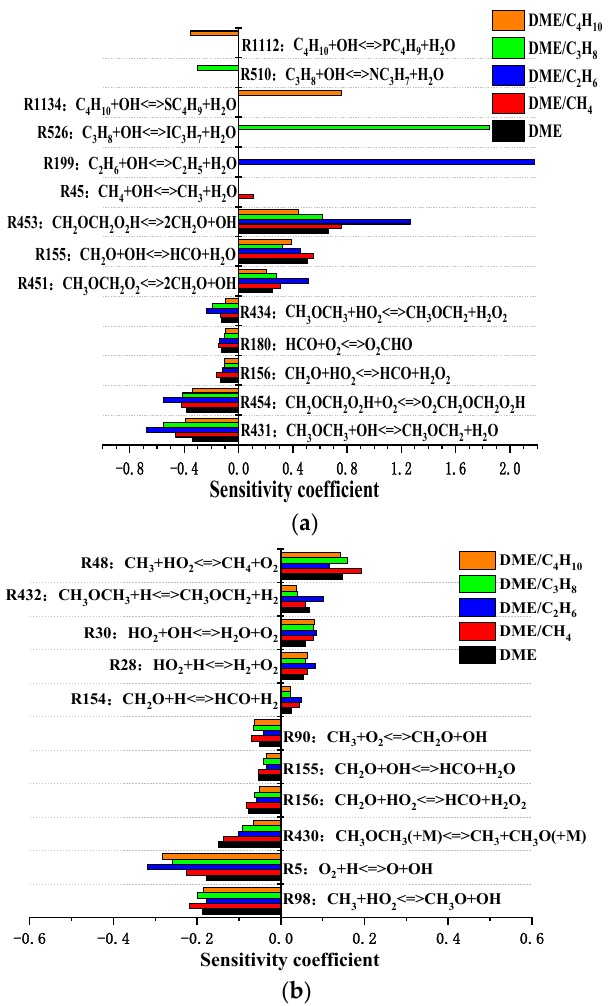
Figure 8. Sensitivity of the ignition delay of DME/C1-C4 alkane mixtures for various compressed temperatures at P c = 20 bar and φ = 0.5: ( a ) T c = 800 K and ( b ) T c = 1500 K.